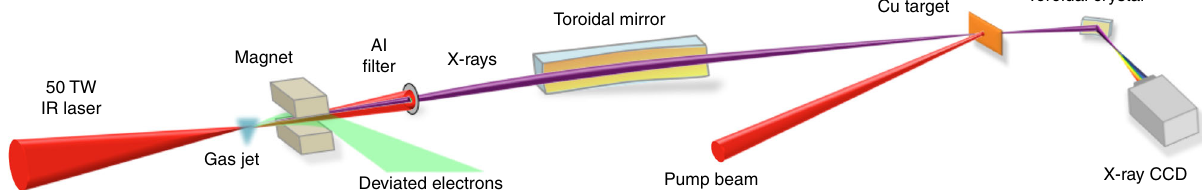
Fig. 2 Setup of the experiment. A 50 TW, 30 fs laser pulse is focused onto a supersonic jet of 99% helium/1% nitrogen gas mixture. The interaction of the laser with the underdense created plasma yields the generation of a betatron X-ray pulse (see Methods for details). The latter is focused by a toroidal mirror on the Cu sample placed at normal incidence. A spectrometer composed of a toroidal crystal and an X-ray charge-coupled device (CCD) camera then record the transmitted spectrum. In parallel, a synchronized laser pulse (pump), with adjustable delay with respect to the X-ray pulse and with adjustable fl uence, is used to heat the Cu sample up to the WDM regime. The absence of jitter is ensured by the fact that the pump laser and the laser- generated X-ray pulse originate from the same laser source